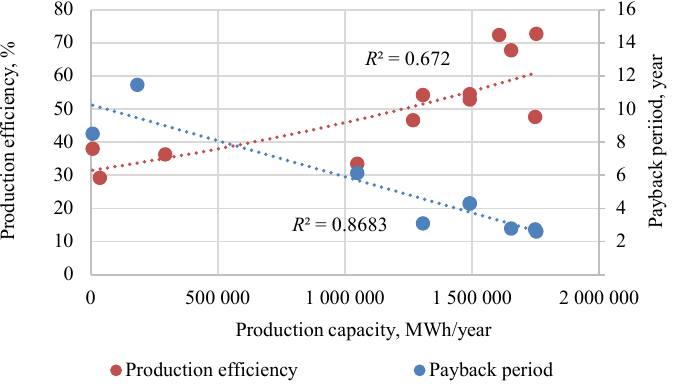
Fig. 5. Correlation between production efficiency, PBP and production capacity.